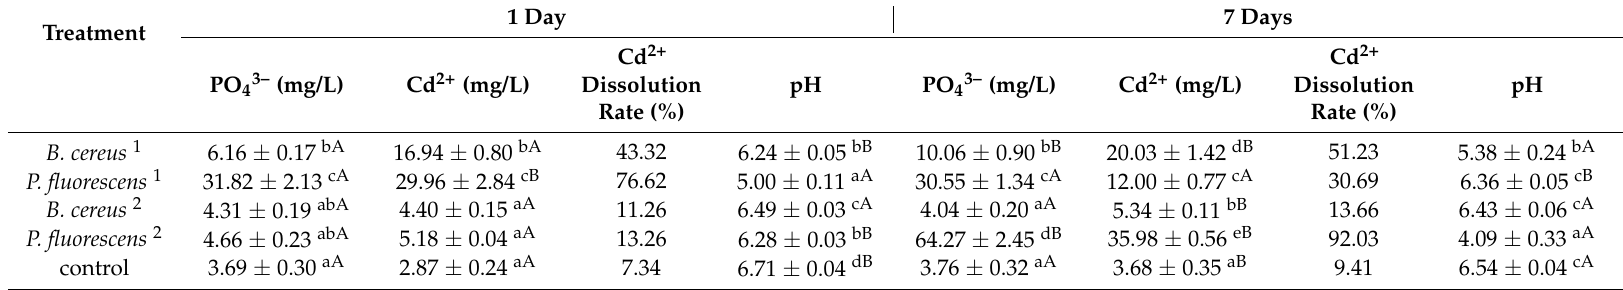
Table 1. Effect of B. cereus and P. fluorescens on the solubility of cadmium (CdCO 3 ) and phosphate (Ca 3 (PO 4 ) 2 ).